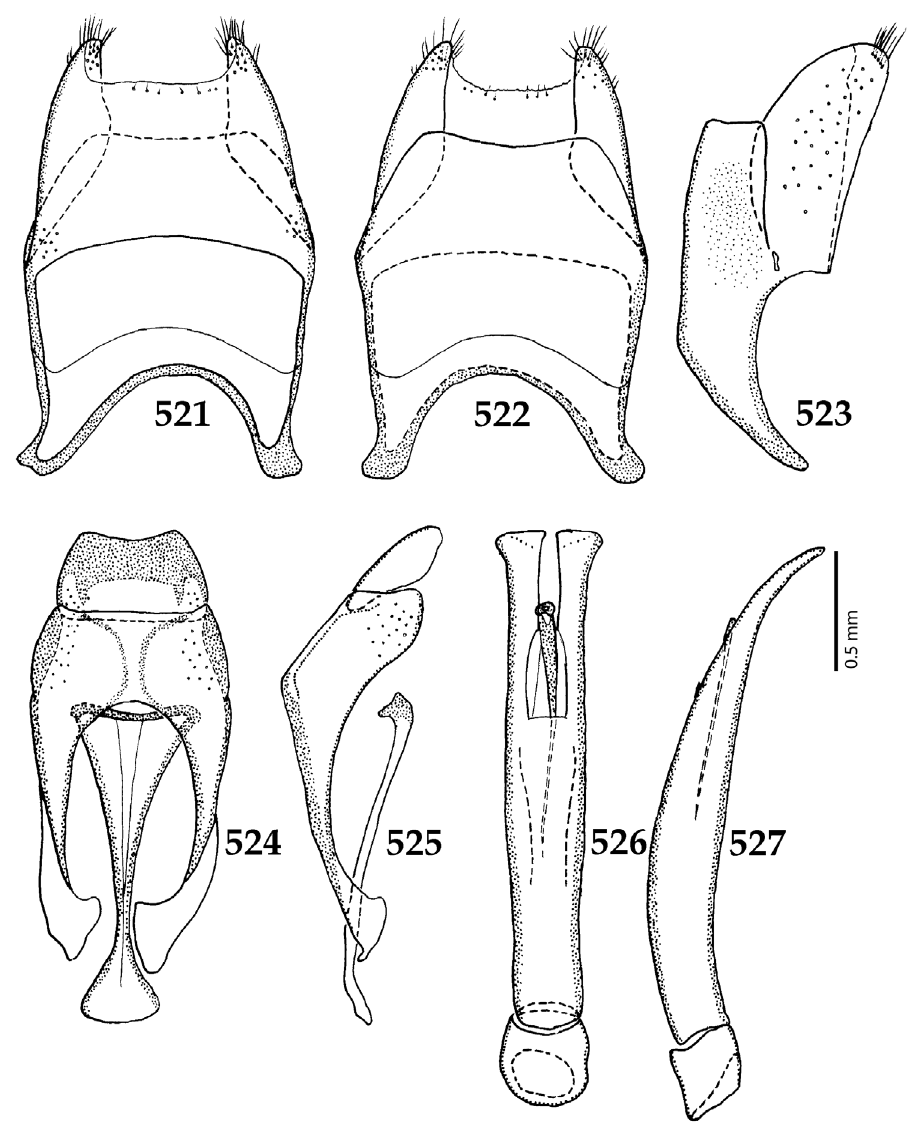
Figures 521–527. 521 Saprinus ( Saprinus ) pseudodetritus sp. n. male terminalia: 8 th sternite + 8 th tergite, ventral view 522 ditto, dorsal view 523 ditto, lateral view 524 male terminalia: 9 th + 10 th tergites, dorsal view; spiculum gastrale, ventral view 525 male terminalia: 9 th + 10 th tergites; spiculum gastrale, lateral view 526 male terminalia: aedeagus, dorsal view 527 ditto, lateral view.